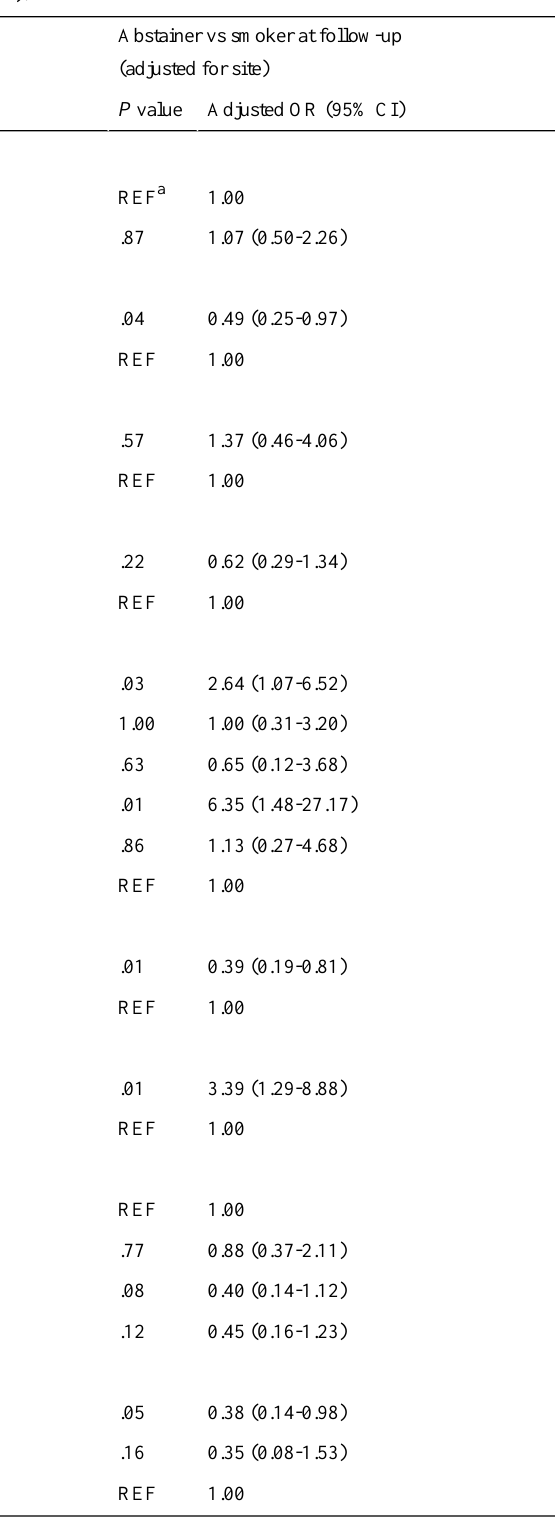
Table 2. Multivariable models predicting smoking at 15-month follow-up